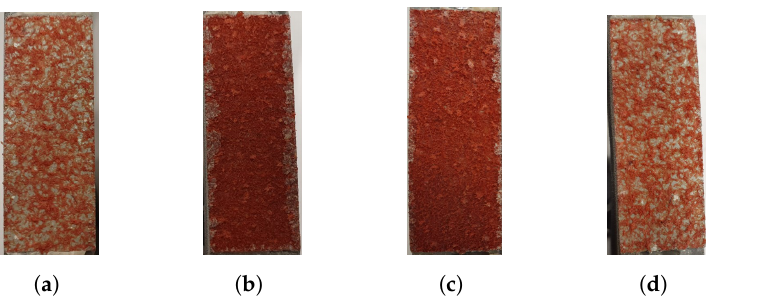
Figure 20. The fractured cores of two specimens, subjected to LC 5, are presented. ( a , c ) contain the lower skins and ( b , d ) contain the upper skins.